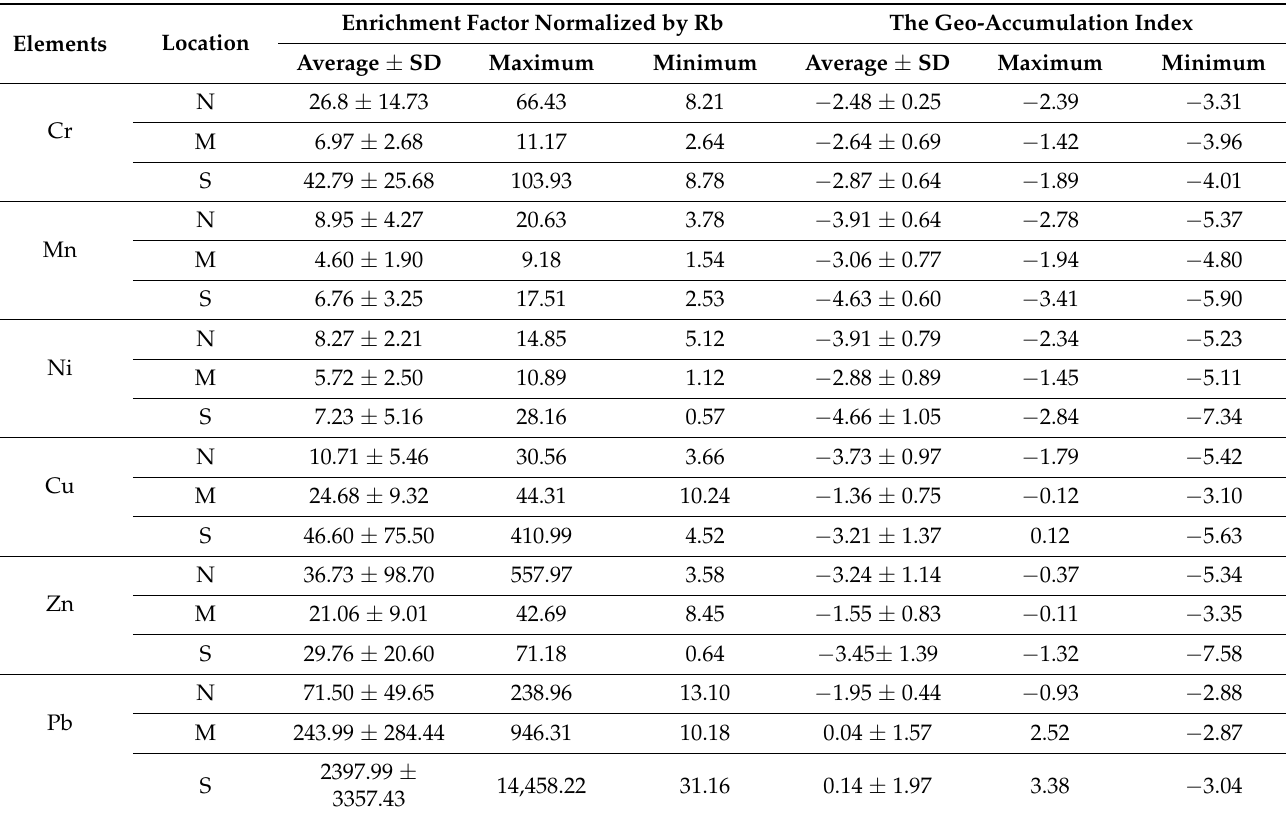
Table 5. The Enrichment Factor and the Geo-accumulation index of the sediment samples from different